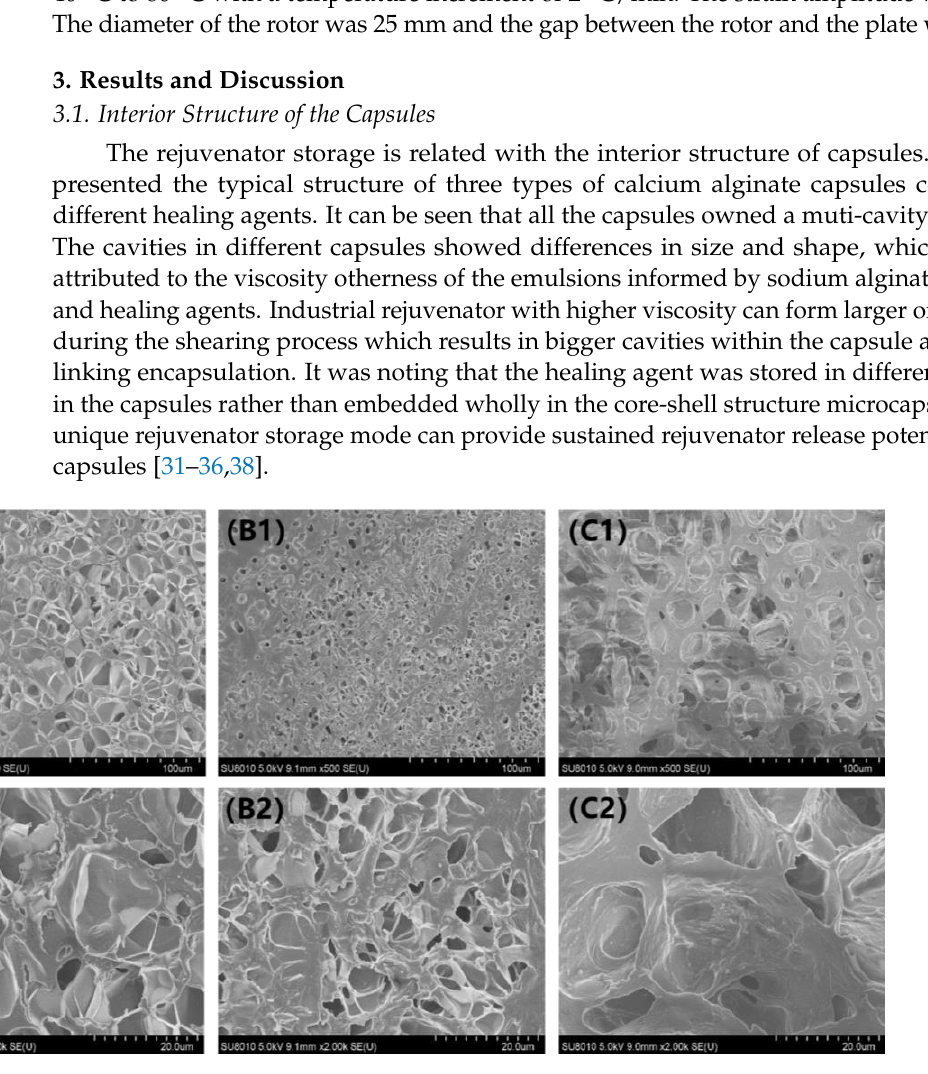
Figure 4. SEM images of capsules: ( A1 , A2 ) vegetable oil capsule, ( B1 , B2 ) waste cooking oil capsule and ( C1 , C2 ) industrial rejuvenator capsule.